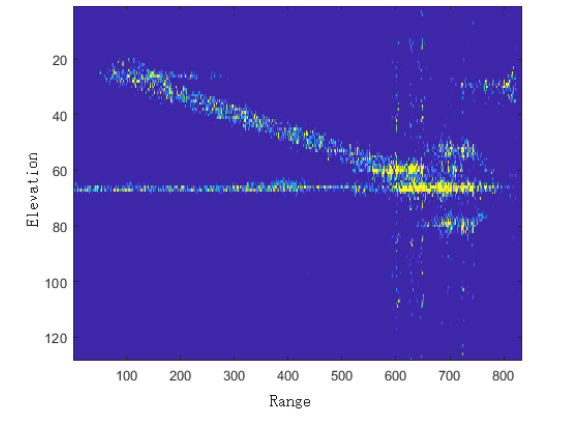
Figure 16. Azimuth cumulative display of building reconstruction